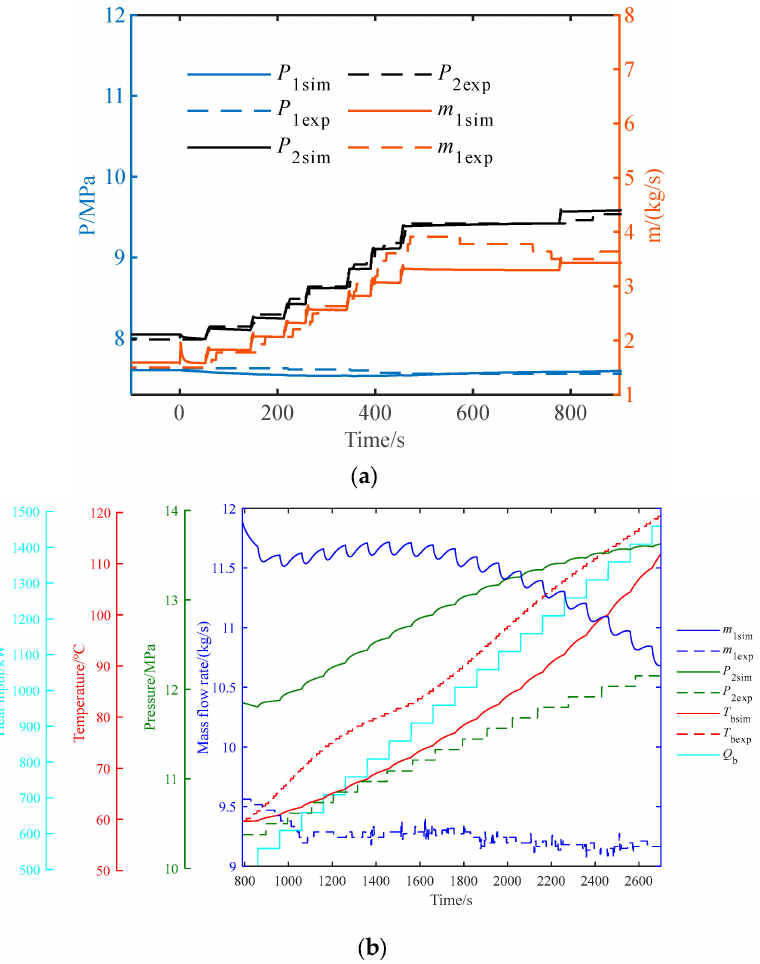
Figure 8. System model verification: ( a ) the test of increased compressor speed; ( b ) the test of increased heating power with constant compressor